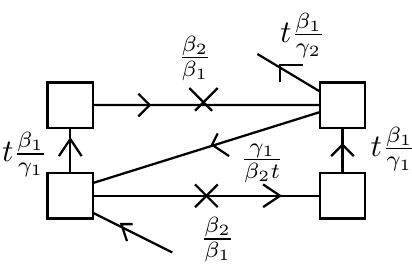
Figure 23 . The tube for k = 2 with (cid:13)ux (1 ; (cid:0) 1) for the (cid:12) symmetry. This can be obtained through closing punctures of free trinions and through the (cid:12)ve dimensional computation. The two punctures are of the same color and sign.